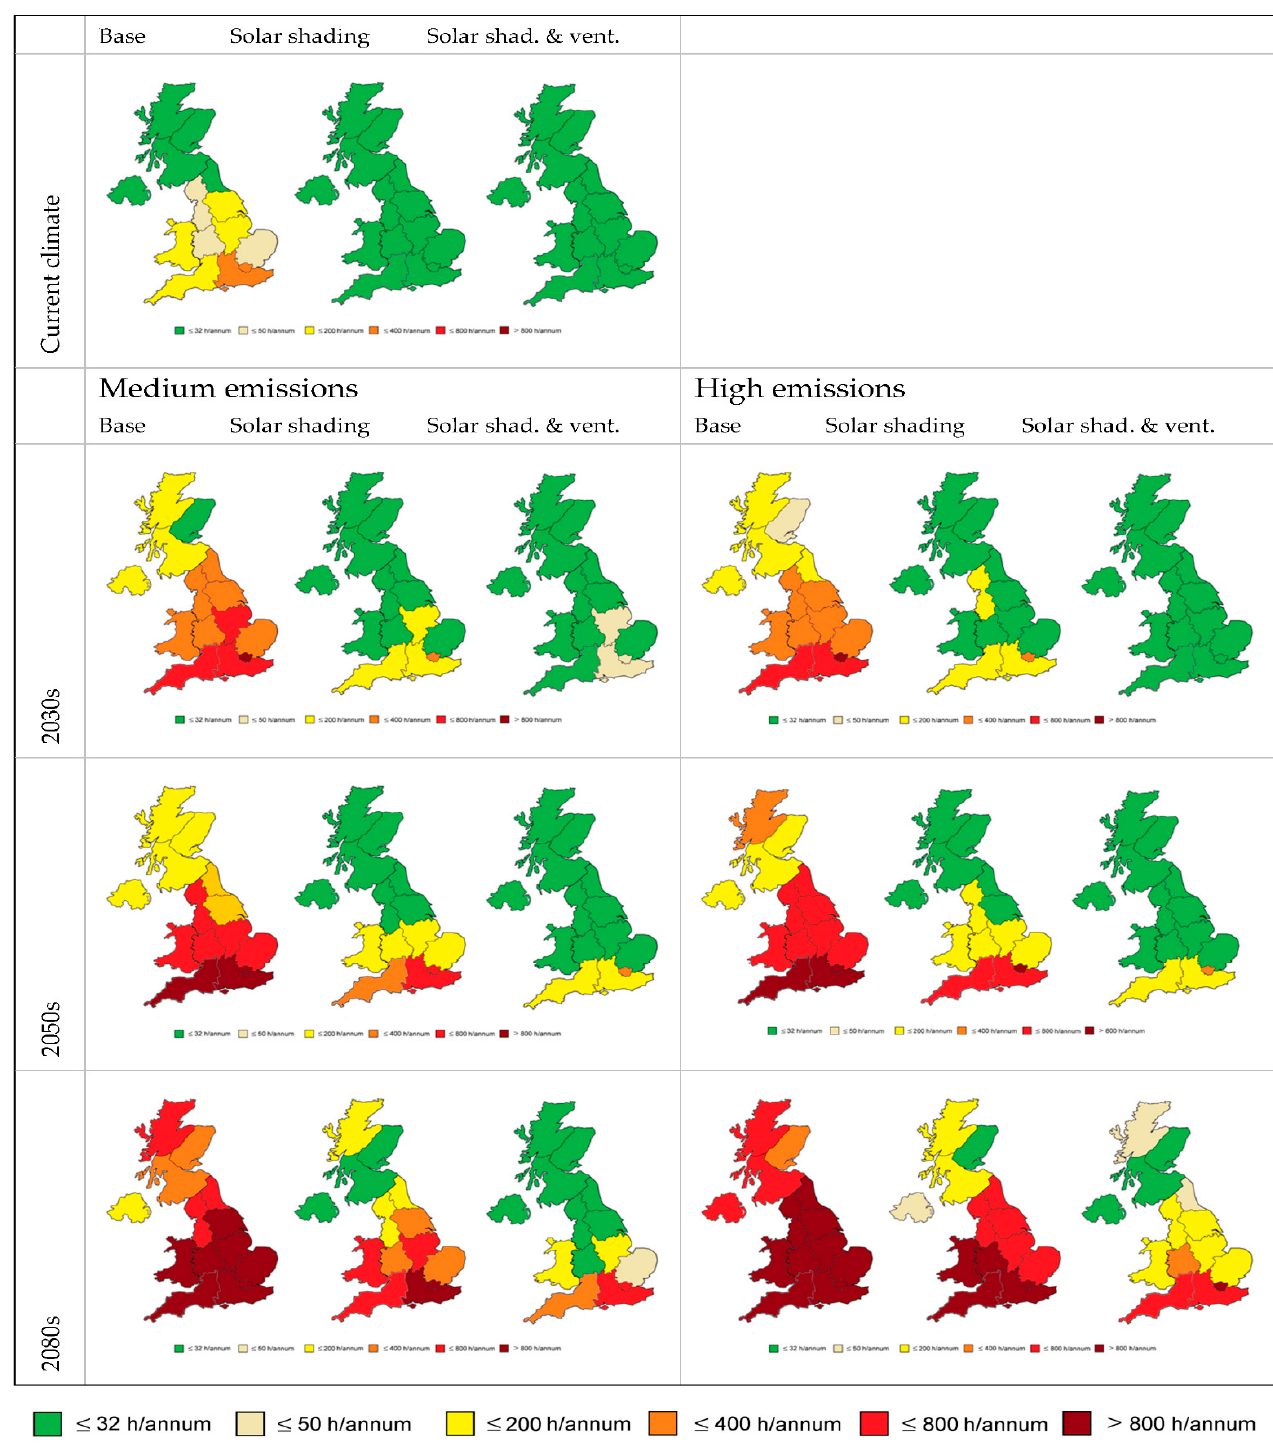
Figure 14. Maps showing hours of bedroom overheating by region, decade, and emissions scenario.